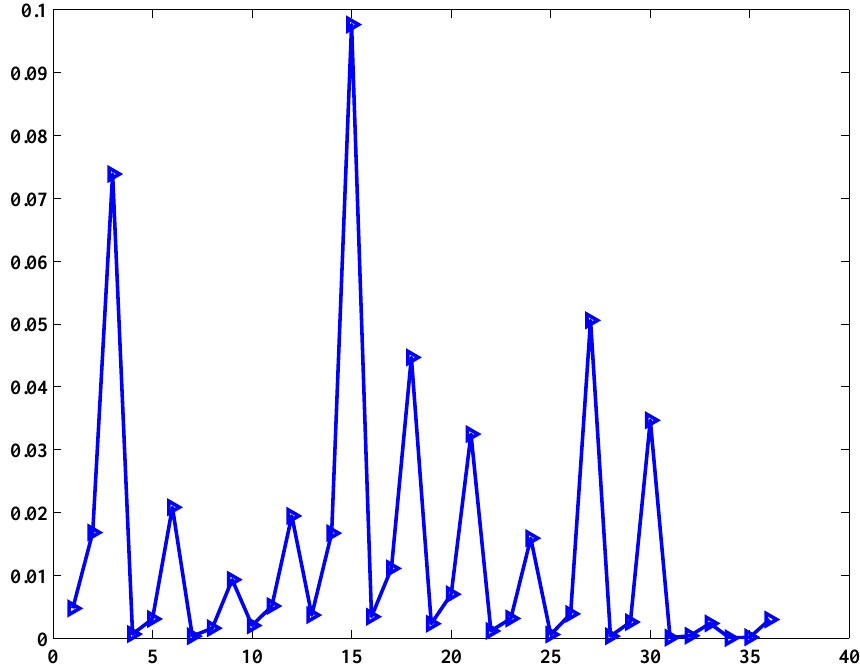
Figure 6. Fog density F den of the 36 sample images (12 images with three fog density levels) from the “lindau” database [20] evaluated using our method with default